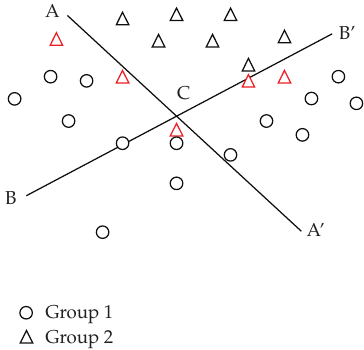
Figure 1: A two-group discriminant problem in two